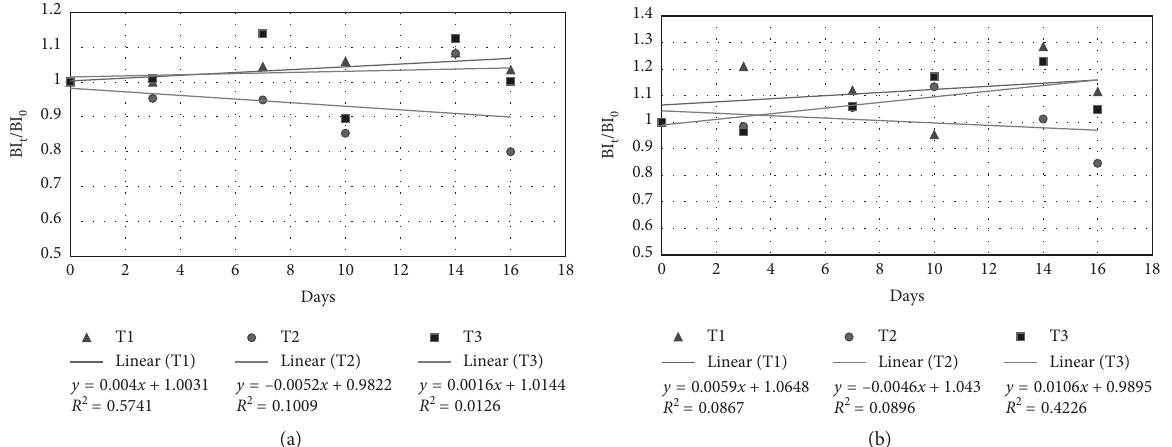
Table 3: Physicochemical parameters of pretreated leaves of Valeriana stored in light condition. Analyses on samples